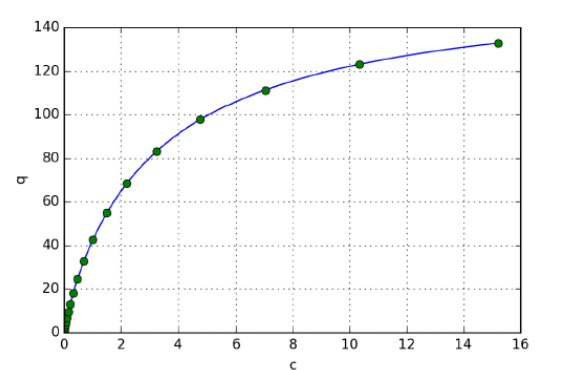
Figure 2. Comparison of the original bi-Langmuir isotherm (blue line) and the isotherm points determined by the inverse method (green dots).